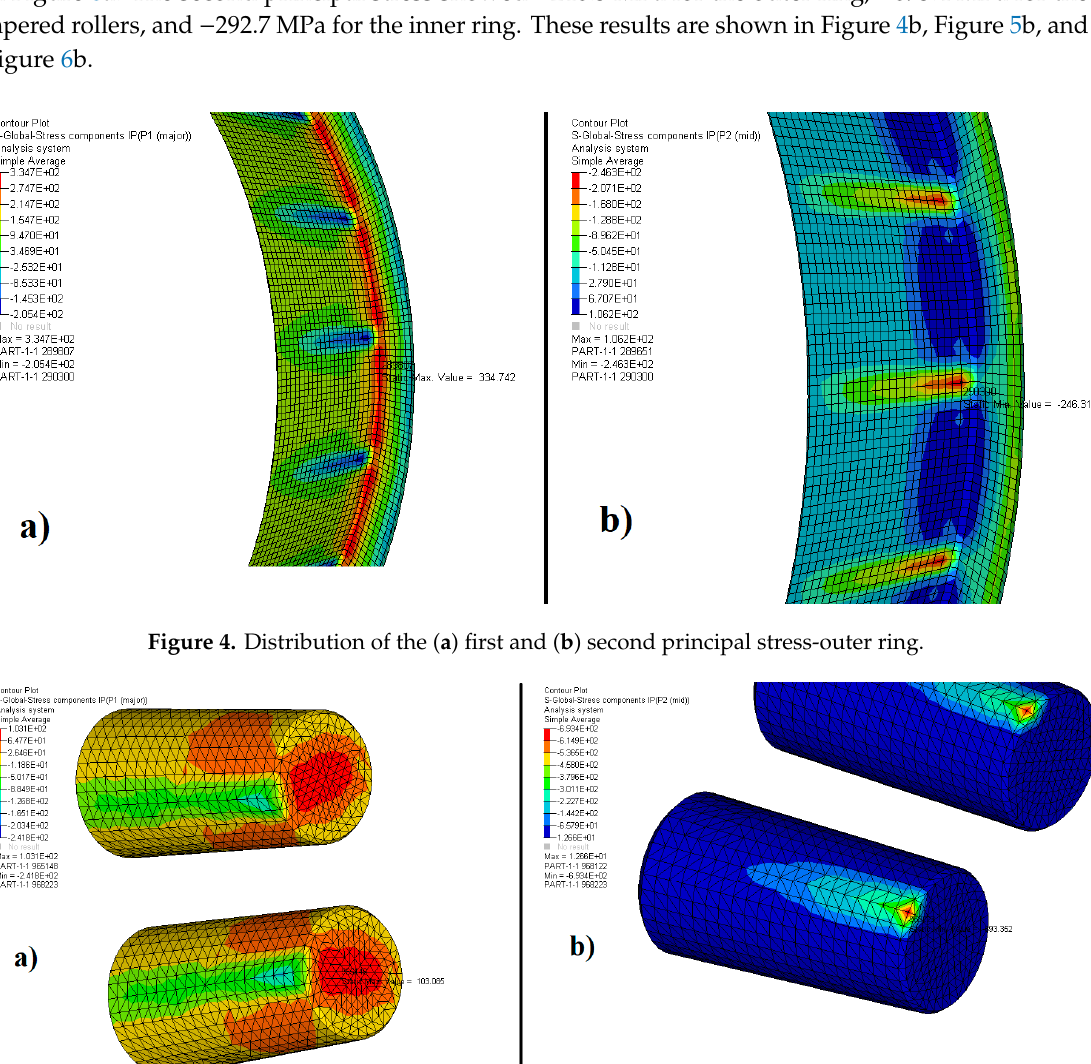
Table 4. Principal stresses in tapered roller bearing-finite element analysis.